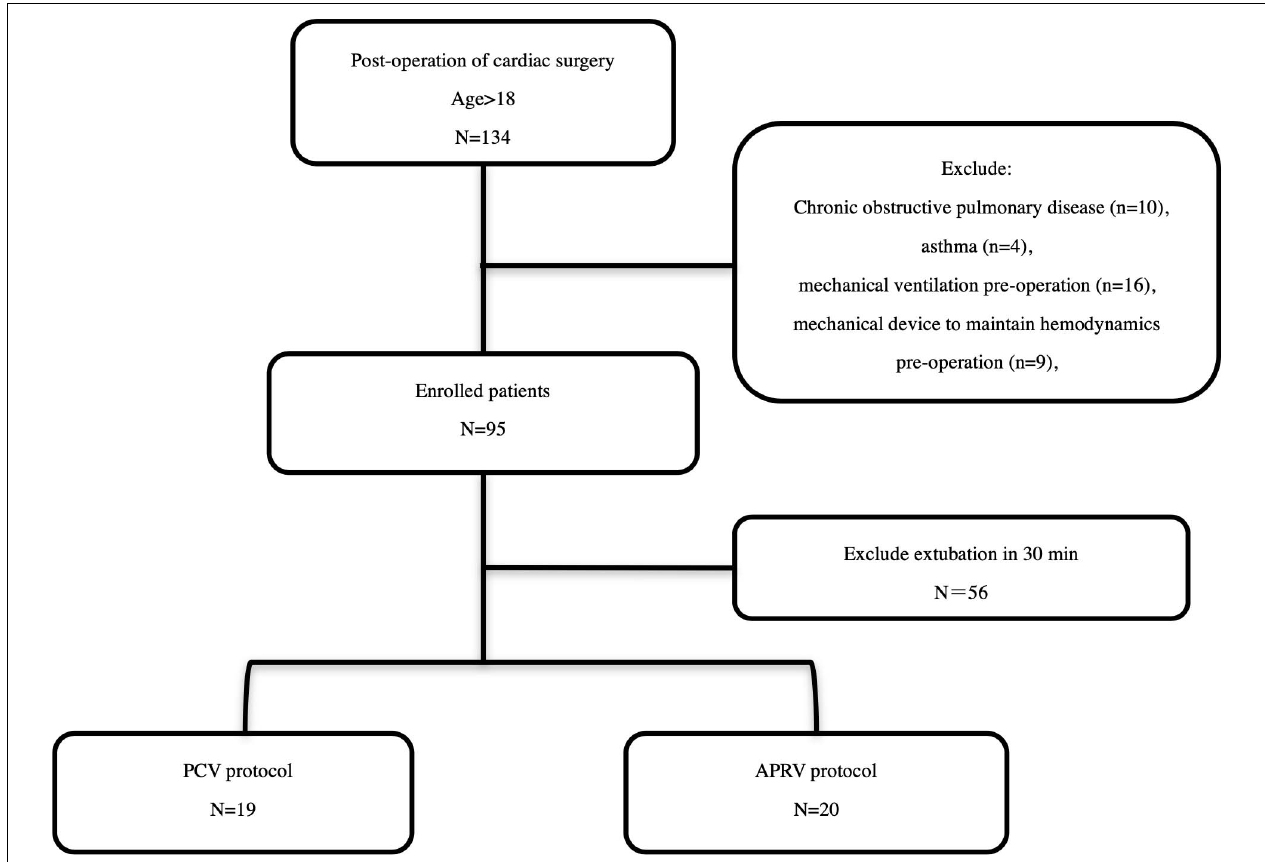
FIGURE 1 | Study Enrollment and study protocol. In total, 138 patients were screened in the present study. Ninety-five patients were enrolled, and ultimately 39 patients were randomized.